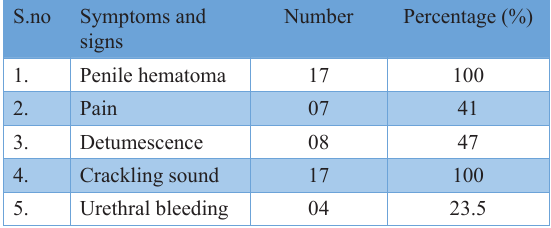
Table 1. Symptoms and signs in patients with penile fractures